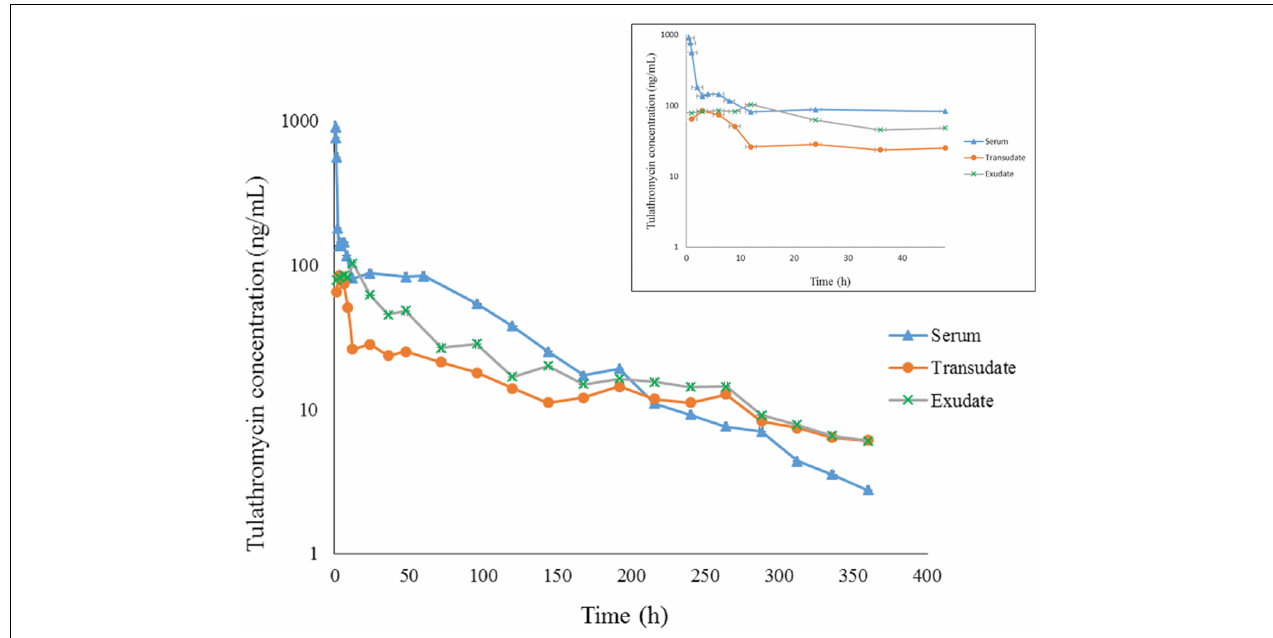
FIGURE 1 | The concentration-time curve for tulathromycin in serum, transudate and exudate after i.v. administration at a dosage of 2.5 mg/kg body weight (for clarity the small graph depicts the drug concentrations in the first 48 h post-administration).